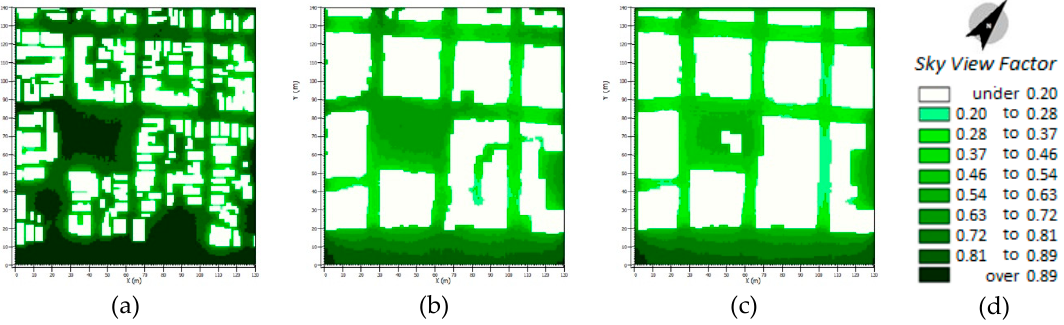
Figure 8. Sky view factor results for ( a ) Sprawl Morphology (urban form data: 1930); ( b ) Medium Morphology (urban form data: 1950); ( c ) Density Morphology (urban form data: 2018); and ( d ) Color scale.